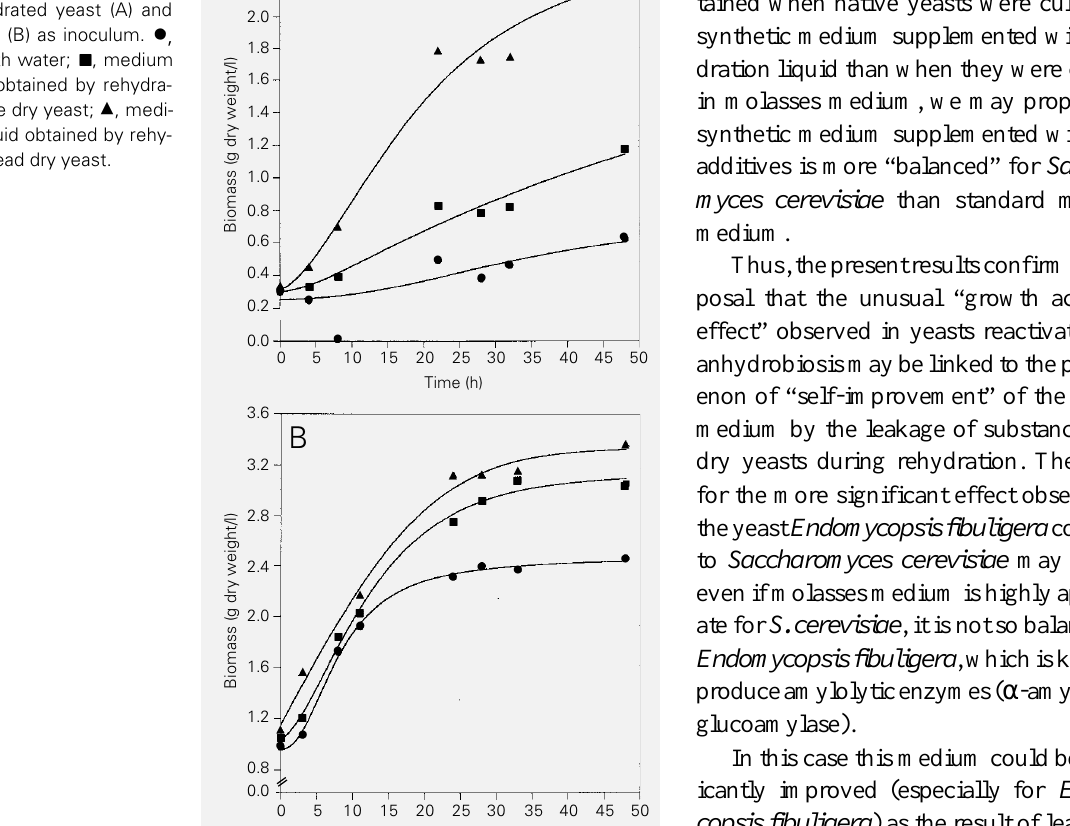
Figure 2 - Biomass accumulation during culture of Saccharomyces cerevisiae in synthetic medium using dehydrated yeast (A) and native yeast (B) as inoculum. ` , Medium with water; (cid:224) , medium with liquid obtained by rehydra- tion of viable dry yeast; £ , medi- um with liquid obtained by rehy- dration of dead dry